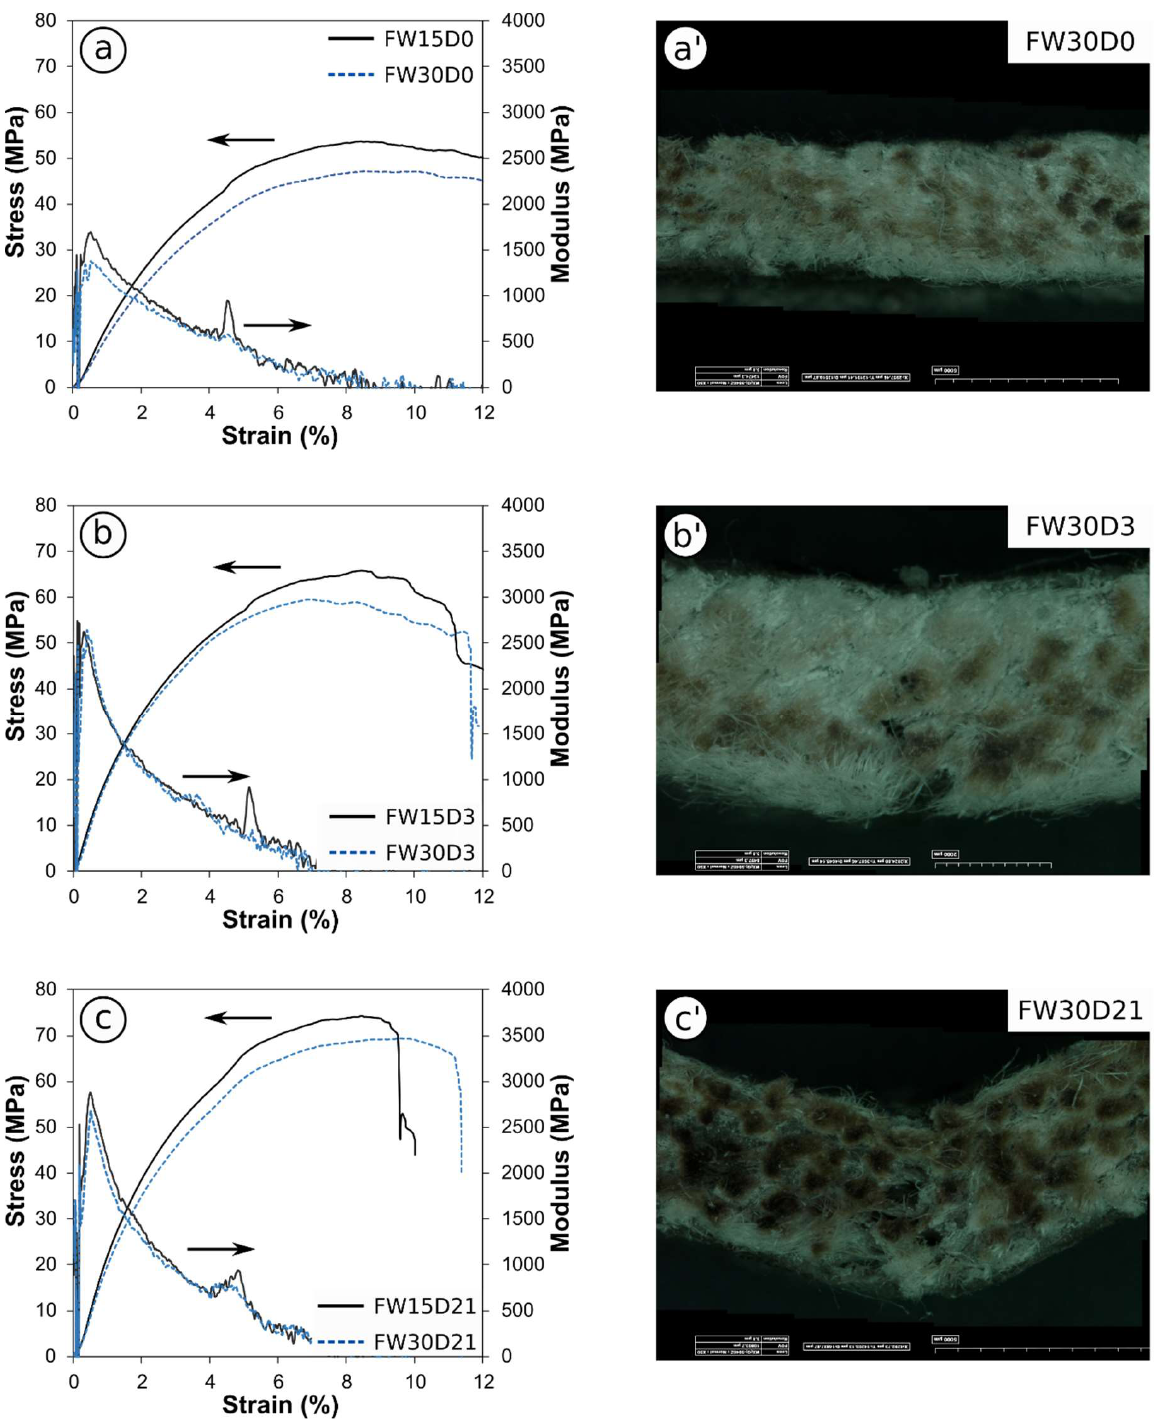
Figure 3. Stress and modulus vs. strain plot at varying wet–dry times for flax laminates: ( a , a ’) 0 days; ( b , b ’) 3 days; ( c , c ’) 21 days of dry time.